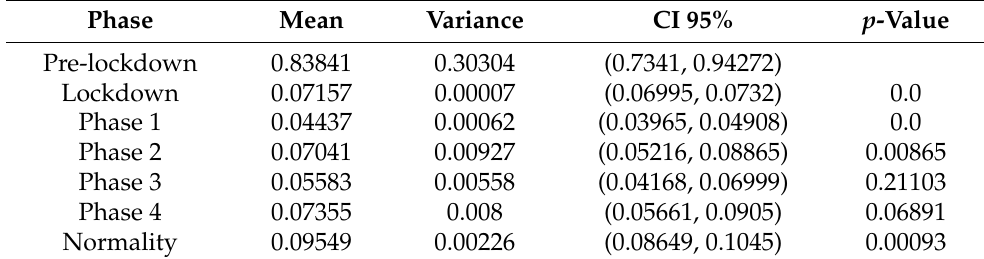
Figure 7. A distribution of the values for β for the different stages of lockdown in the different provinces of Italy. Table 3. Statistics for the Italian Histogram